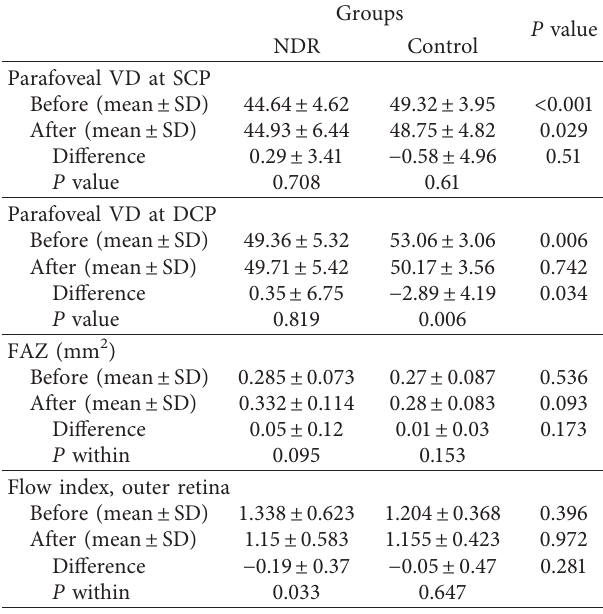
Table 2: Comparison of the OCTA parameters between NDR and control groups before and after the hyperoxic